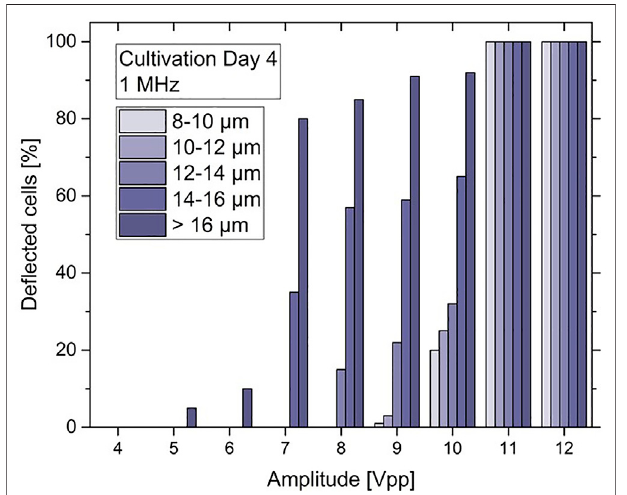
FIGURE 8 | Bar chart of the de fl ected C. cohnii cells after on-set of DEP voltage exhibiting an amplitude between 4 and 12 V pp and a constant frequency of 1 MHz. Cells are categorized into size groups. For large cells of more than 16 µm in diameter the nDEP effect starts to occur at 5 V pp . At 10 V pp cells from all size groups are affected by nDEP to different amounts, while for high amplitudes at 11 and 12 V pp all cells experience an nDEP force regardless of their size.